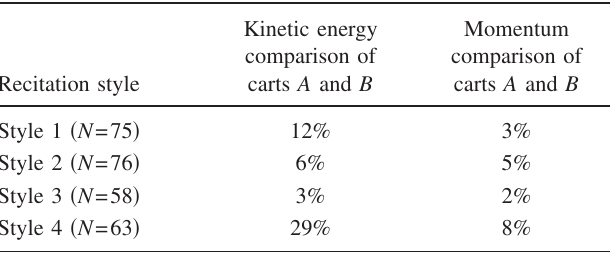
TABLE VIII. Students who acknowledged but incorrectly ap- plied the theorems on post-test question 2. Note that no students acknowledged these theorems on the pretest without applying them correctly.